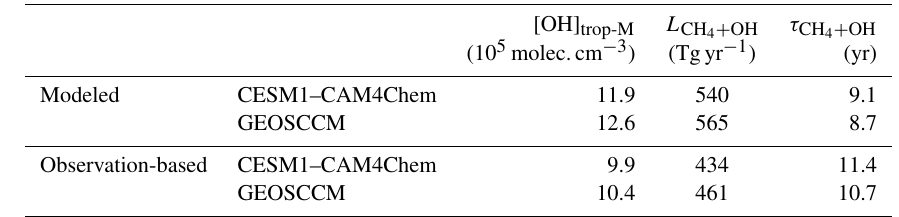
Table 2. Modeled and observation-based estimates of global [OH] trop-M , CH 4 sink by tropospheric OH ( L CH 2009, and the CH 4 lifetime against tropospheric OH ( τ CH